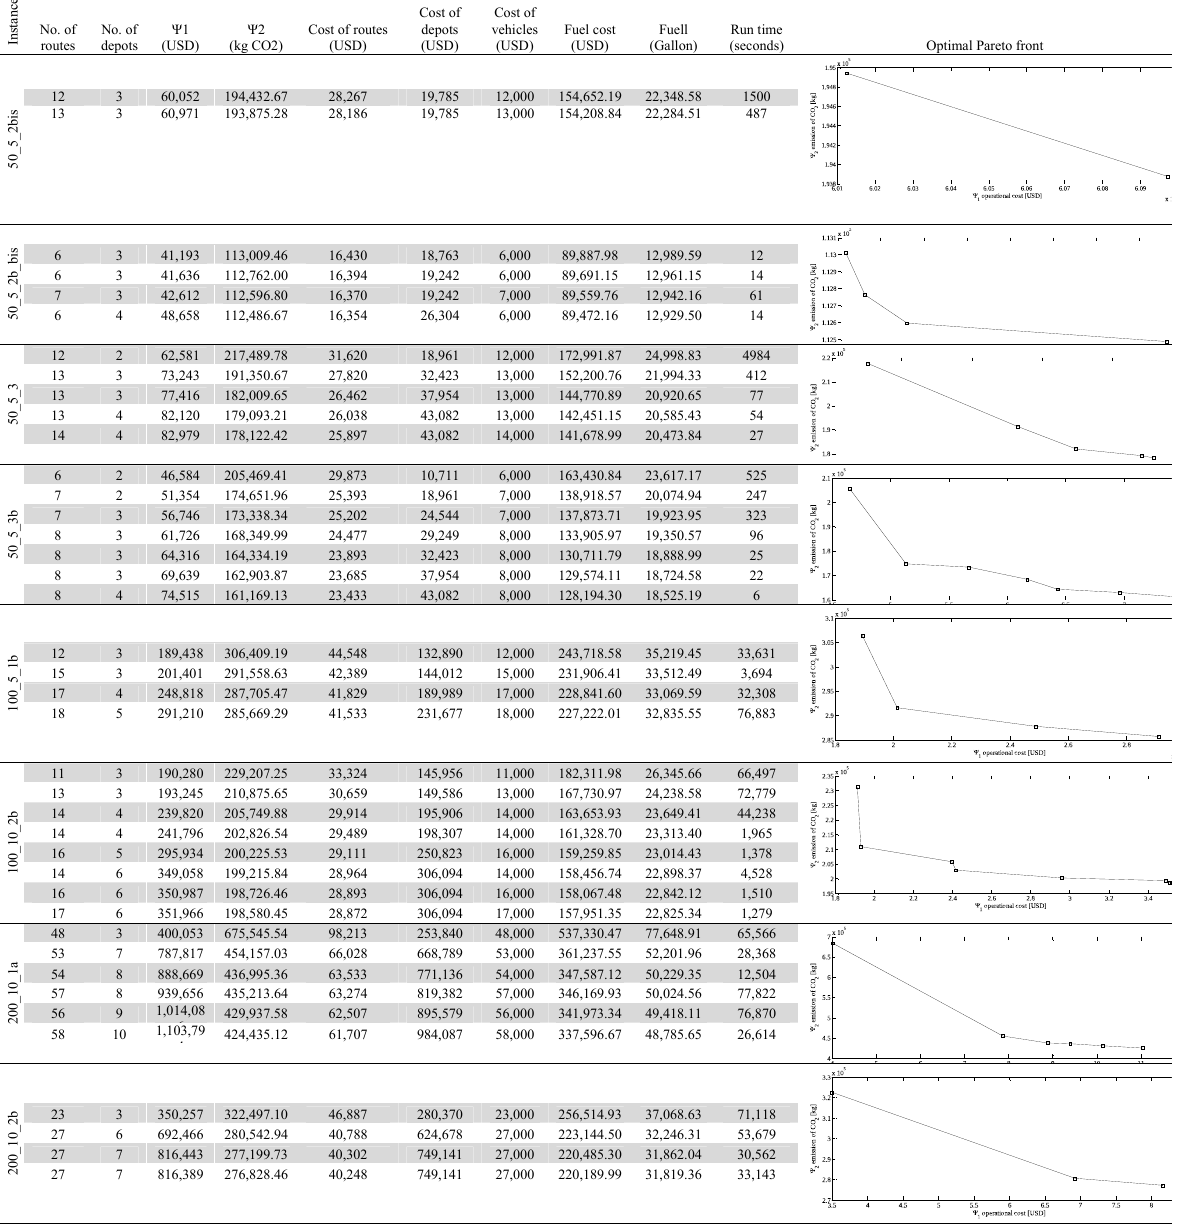
Computational results for instances used by Prins et al. (2007) (Continued) ce a n No. of s t I n